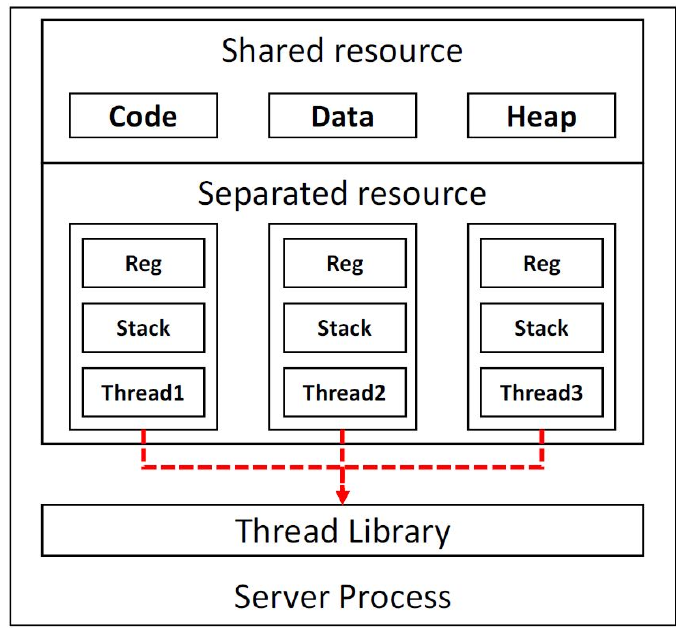
Figure 5. Multithreading in the server process.